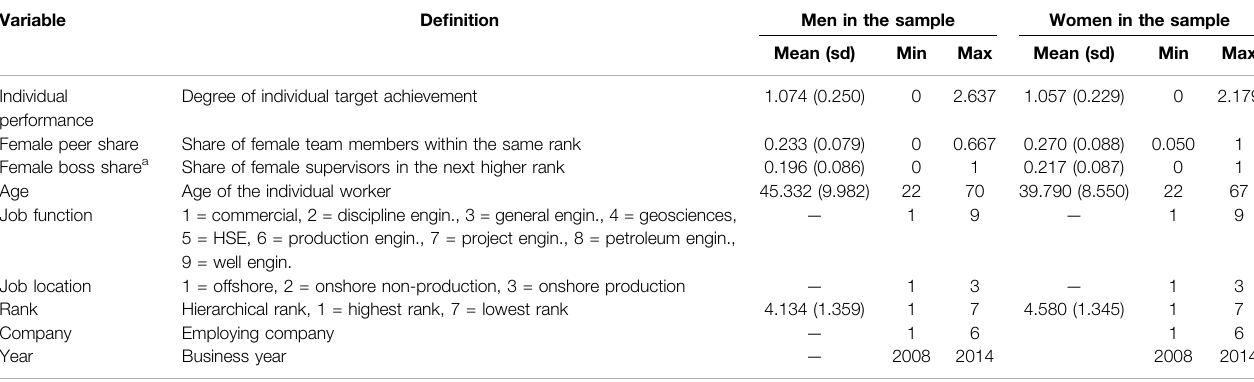
TABLE 1 | Descriptive statistics of the main variables. Variable